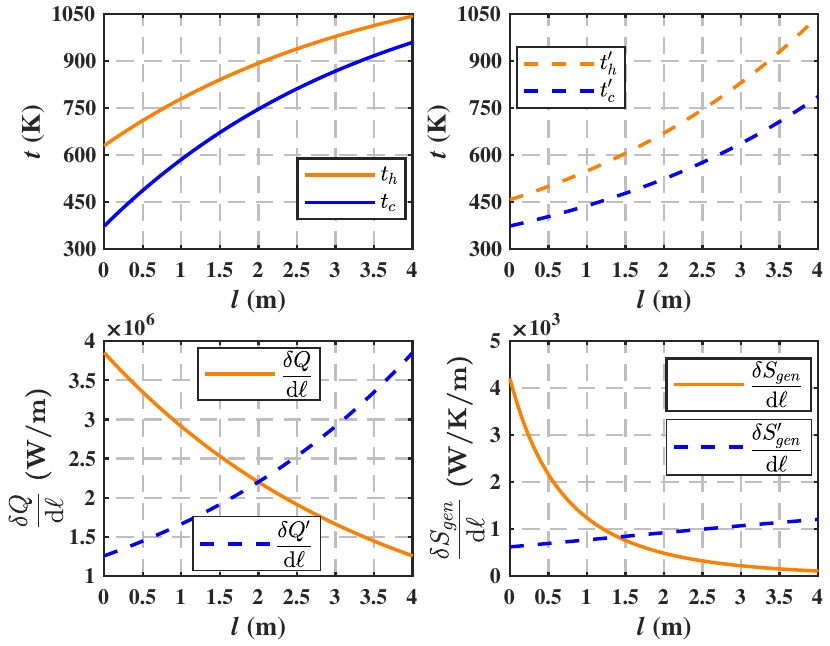
Figure 12. Temperature profiles, local heat transfer rates and entropy generation rates in the helical steam